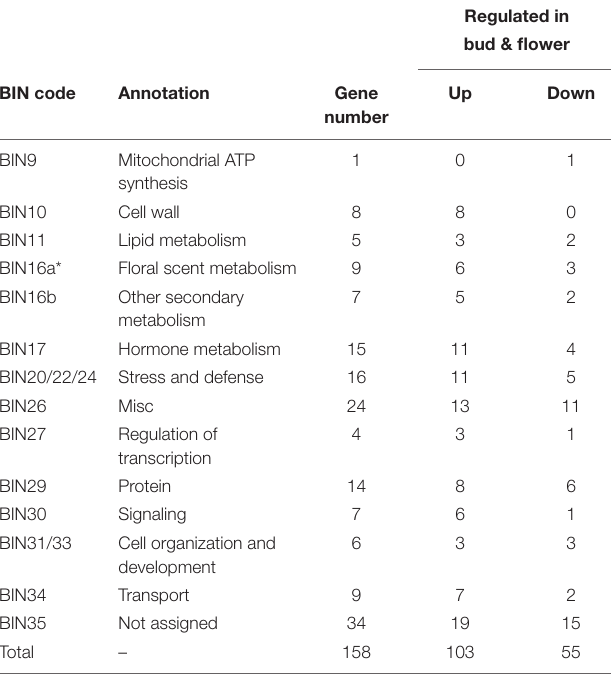
TABLE 1 | Functional categories of the differentially expressed genes that were highly correlated with